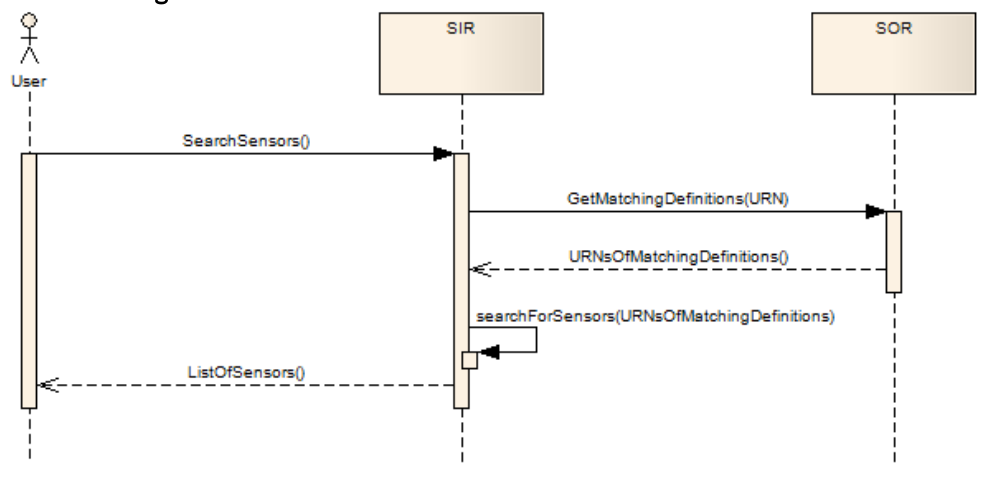
Figure 2. Schema of the interactions between SOR and